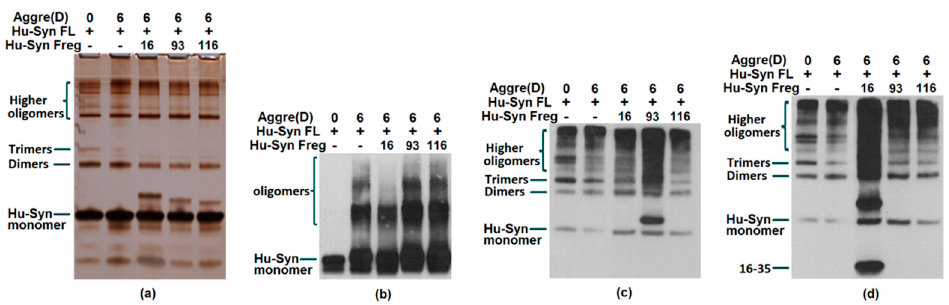
Figure 4. Recombinant protein full-length human α -synuclein aggregation test incubated with synthetic peptides Hu-syn16-35(16), Hu-syn93-115(93) and Hu-syn 116-136(116). Human α -synuclein aggregated with or without fragments after 6 days (6) at 37 ◦ C using an orbital incubator or stored in − 80 ◦ C (0). Since the epitopes could be occupied by the co-incubated fragments, it is better to compare the western blot results probed with di ff erent antibodies in order to confirm conclusions made from the aggregation test. ( a ) Silver staining result; ( b ) Western blot detected by antibody 2A4; α -syn 116-136 promotes full-length α -syn aggregation; ( c ) Western blot detected by antibody G93-115; α -syn 16-35 promotes full-length α -syn aggregation; ( d ) Western blot detected by antibody G16-35, α -syn 93-115 and α -syn 116-136 promote full-length α -syn aggregation. As a result, each of these peptides α -syn 16-35, α -syn 93-115, and α -syn 116-136 could promote full-length α -syn accumulation.